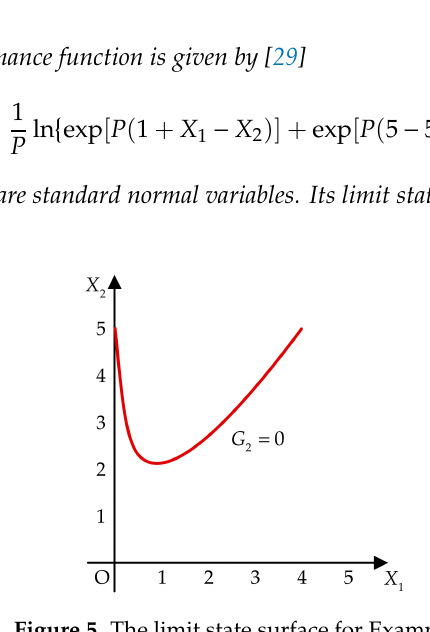
Figure 5. The limit state surface for Example 2.